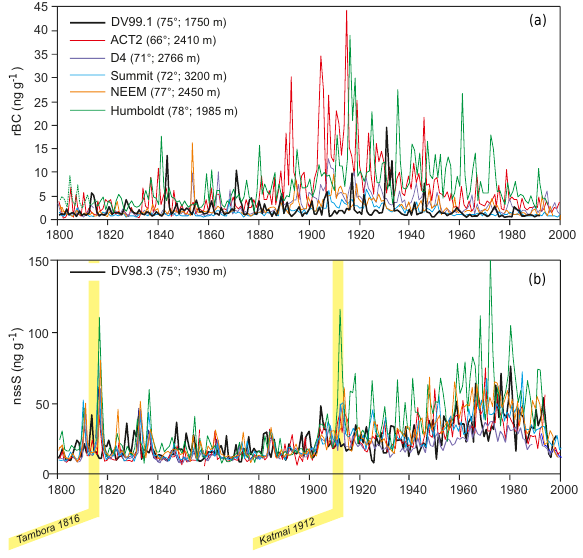
Figure 6. (a) The DV99.1 record of atmospheric rBC deposition since 1800 compared with other records developed from sites in Greenland identified in Fig. 5. All records are presented in 1-year averages. (b) As in (a) but for records of non-sea salt sulfur (nssS). Two volcanic eruption isochron used for correlation in the Green- land cores are highlighted.